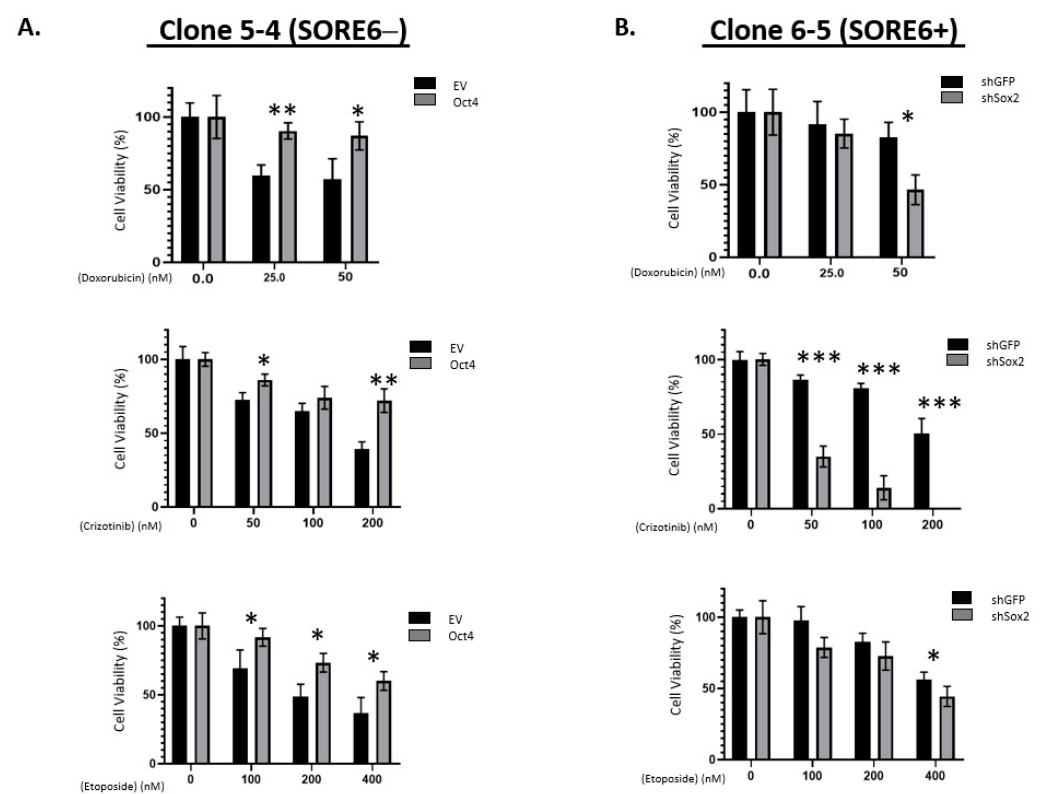
Figure 5. iPS factors enhance chemoresistance of SORE6 clones. ( A ) Overexpression of EV or Oct4 in 5-4 (SupM2 SORE6 − ) cells, followed by treatment with doxorubicin, crizotinib, and etoposide. ( B ) Overexpression of EV or shSox2 in 6-5 (SupM2 SORE6+) cells, followed by treatment with doxorubicin, crizotinib, and etoposide. Results are mean ± SEM, * p < 0.05, ** p < 0.01, *** p < 0.001.